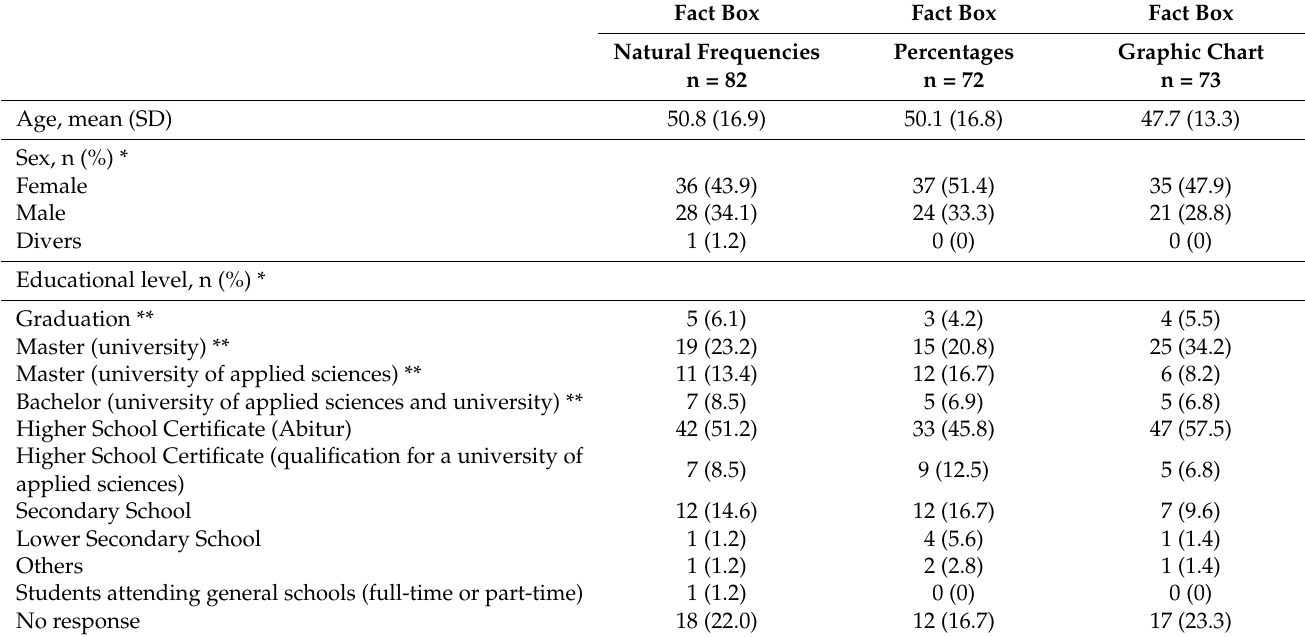
Table 1. Baseline characteristics of participants (n =